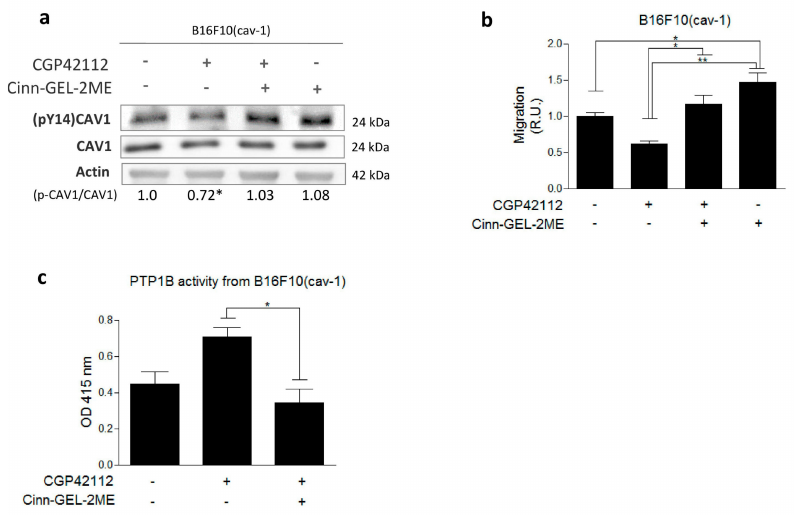
Figure 4. Angiotensin II type-2 receptor (AT2R) activation decreases non-receptor protein tyrosine phosphatase 1B (PTP1B) activity in B16F10(cav-1) cells. ( a ) Lysates of B16F10(cav-1) cells pretreated